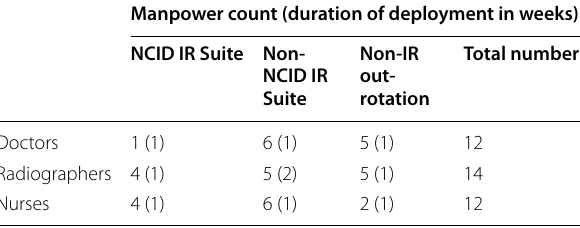
Table 4 Manpower deployment during the COVID-19